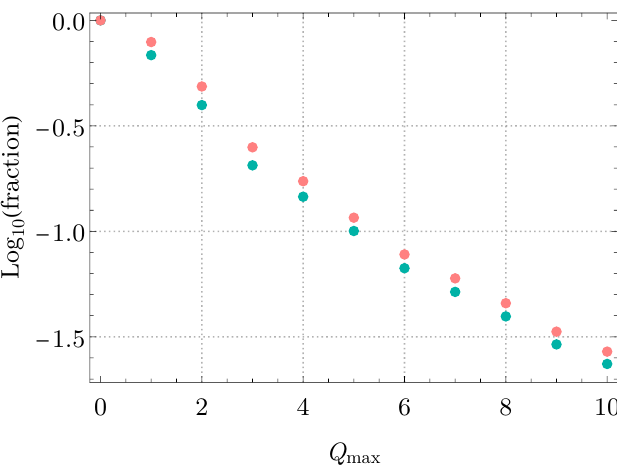
Figure 2 . The fraction of anomaly-free u (1) X extensions of the SM, including three right-handed neutrinos, that embed in any semi-simple gauge model. This is plotted as a function of Q maximum absolute charge in the solution X after clearing common divisors. The red points consider embedding each sm ⊕ u (1) in any g that is free of local anomalies, while the green points restrict X to g for which there is a corresponding gauge group that is further free of global anomalies. We see that, out to Q = 10 , to which the anomaly-free atlas was charted in [19], roughly 2.5 % of max solutions are